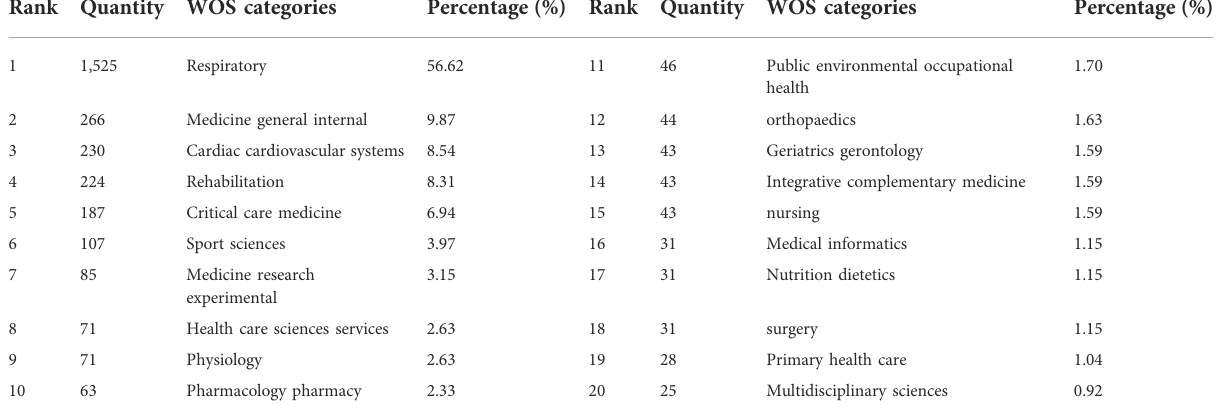
TABLE 4 The top 20 subject categories in the studies of the COPD and exercise therapy. Rank Quantity WOS